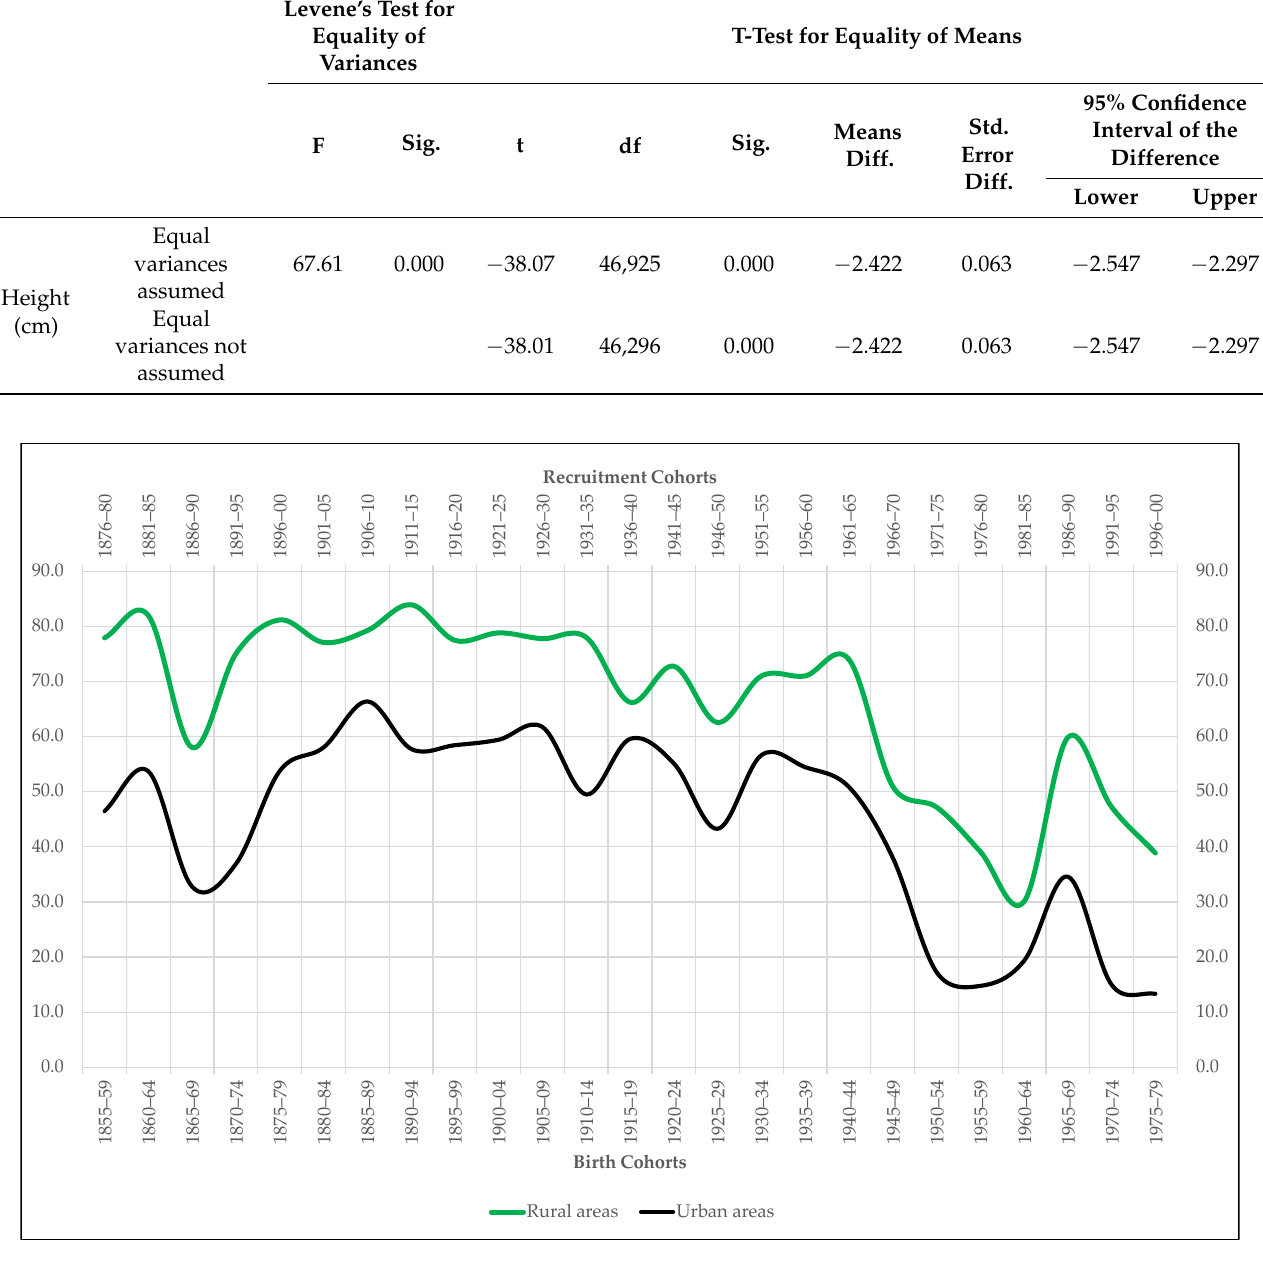
Figure 6. Proportion of recruits included in the sample Extremadura who declare working in the agrarian sector (percentage over the total agrarian and non-agrarian recruits).